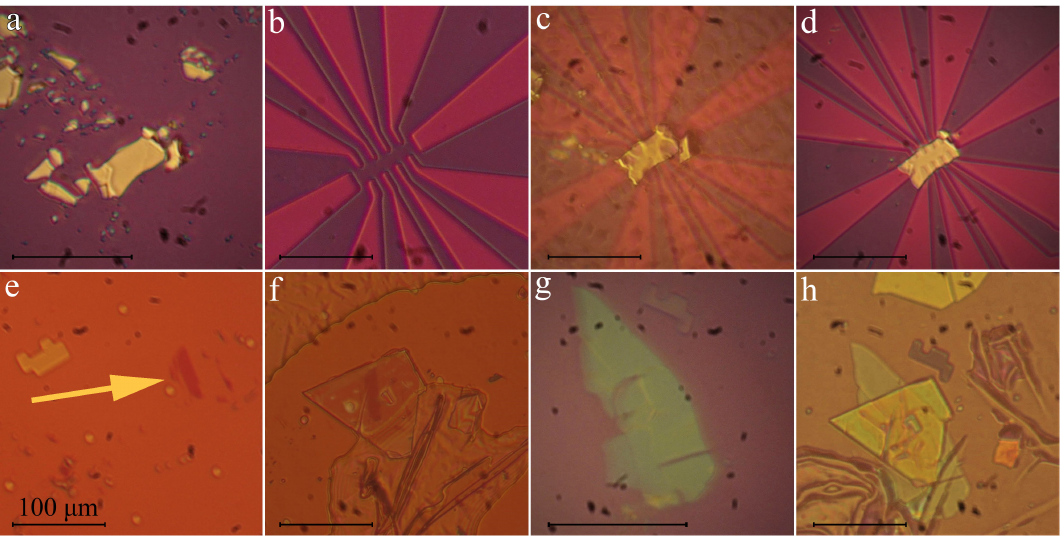
Figure 5. ( a–d ) Transfer process of Sr x Bi 2 Se 3 to prepared gold contacts ( e–h ) Stacking process for heterostructure hBN-WSe 2 -hBN.